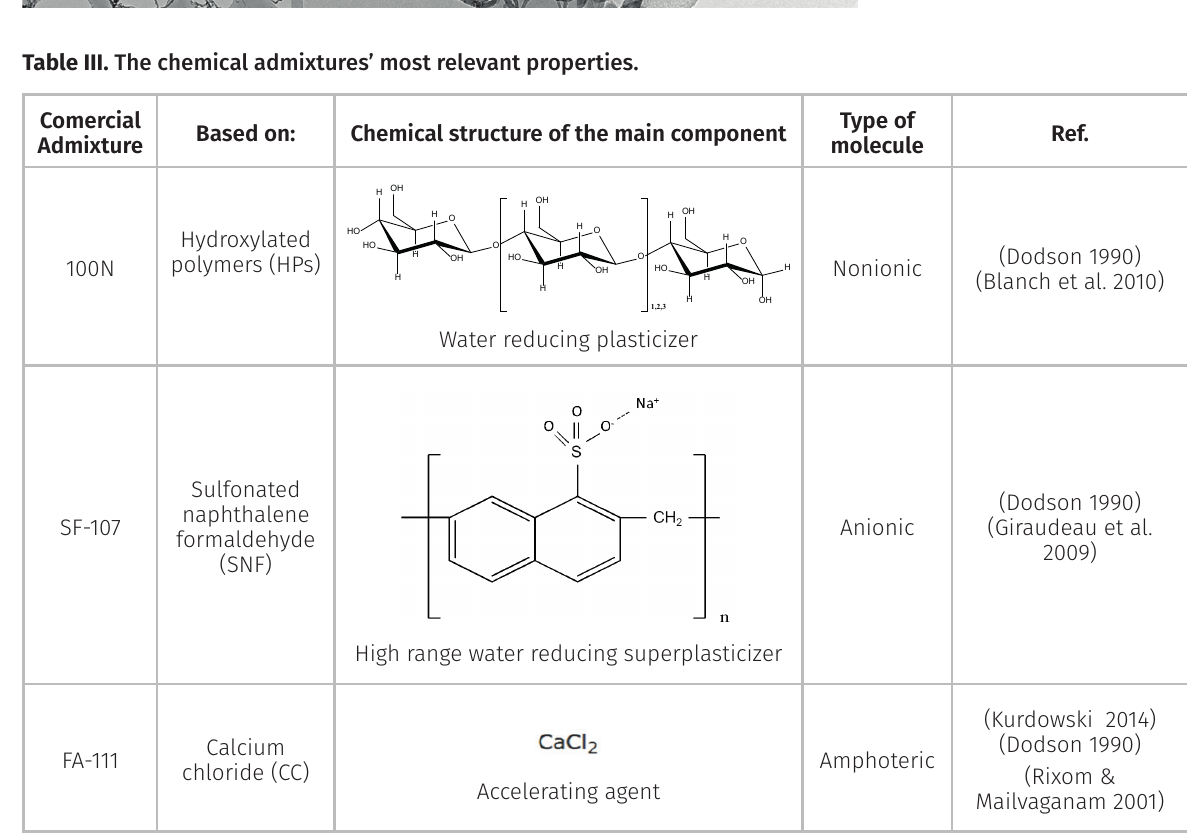
Figure 2. Transmission electron microscope images of